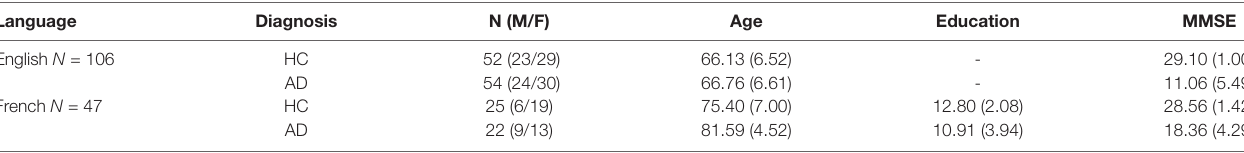
TABLE 1 | Sample characteristics for English and French